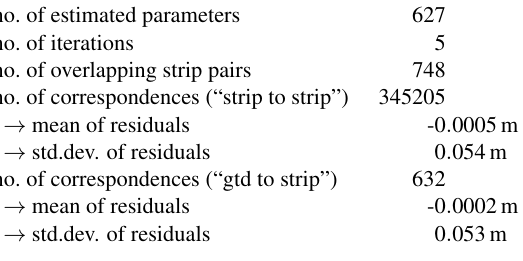
Table 3: Strip adjustment results (gtd = ground-truth data).